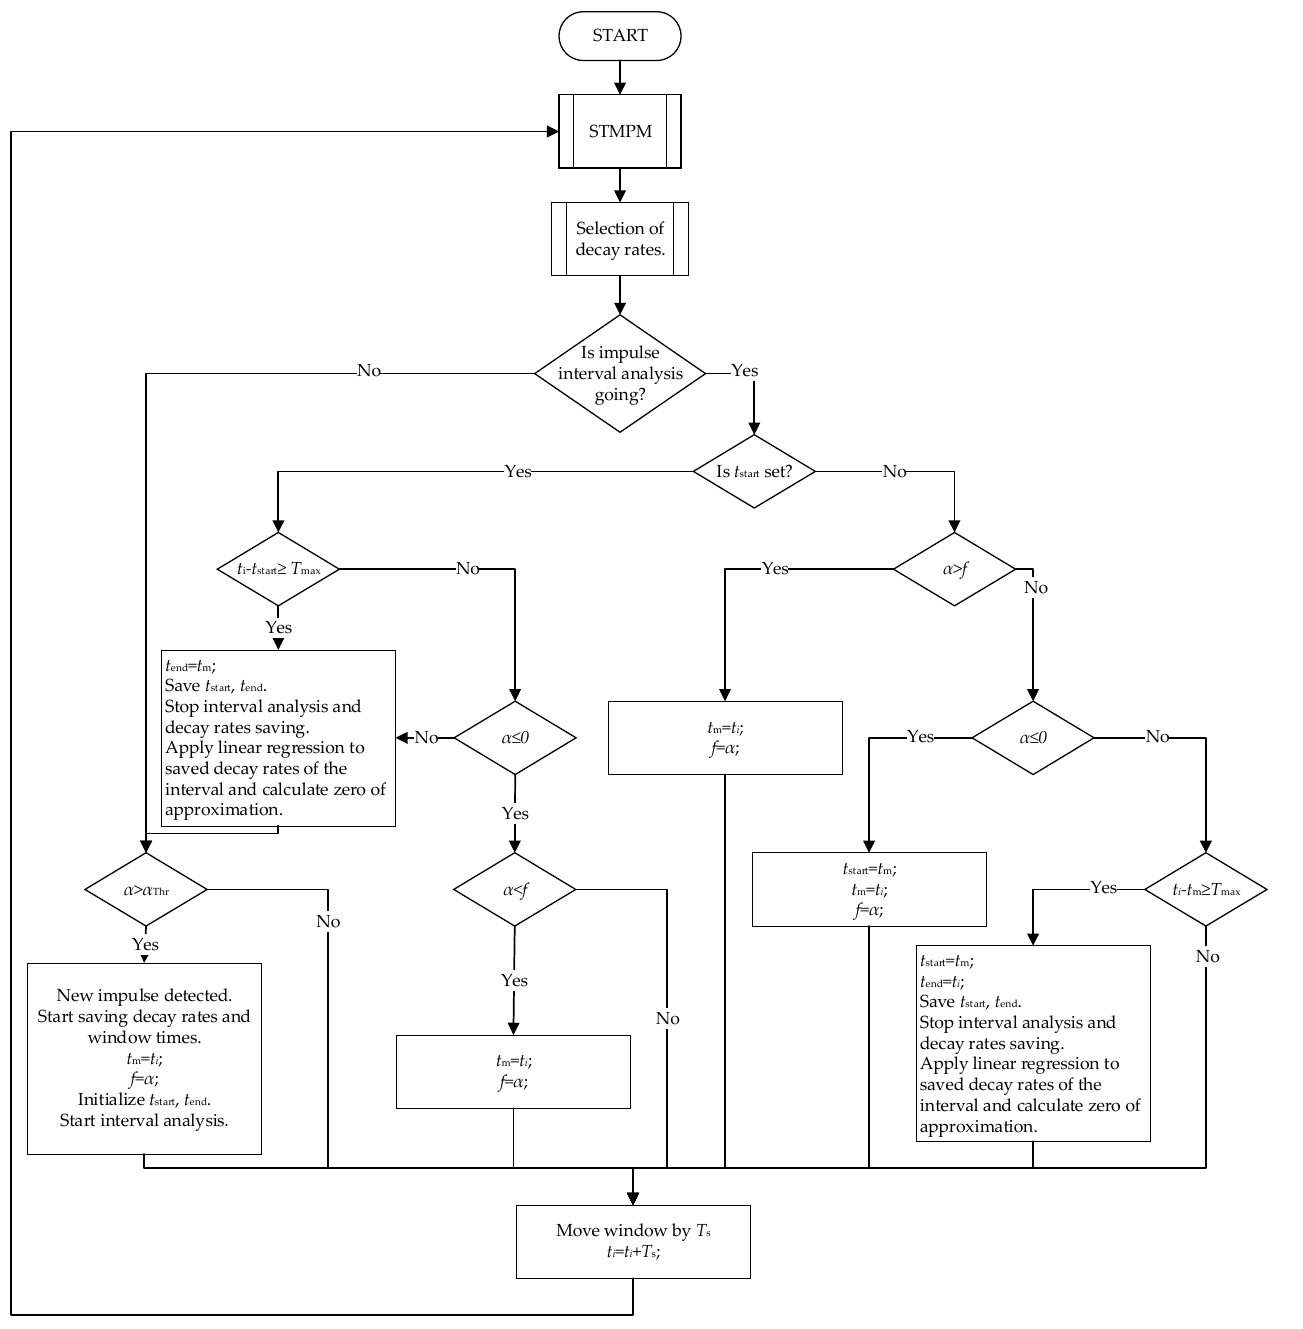
Figure 4. The algorithm of pulse identification.